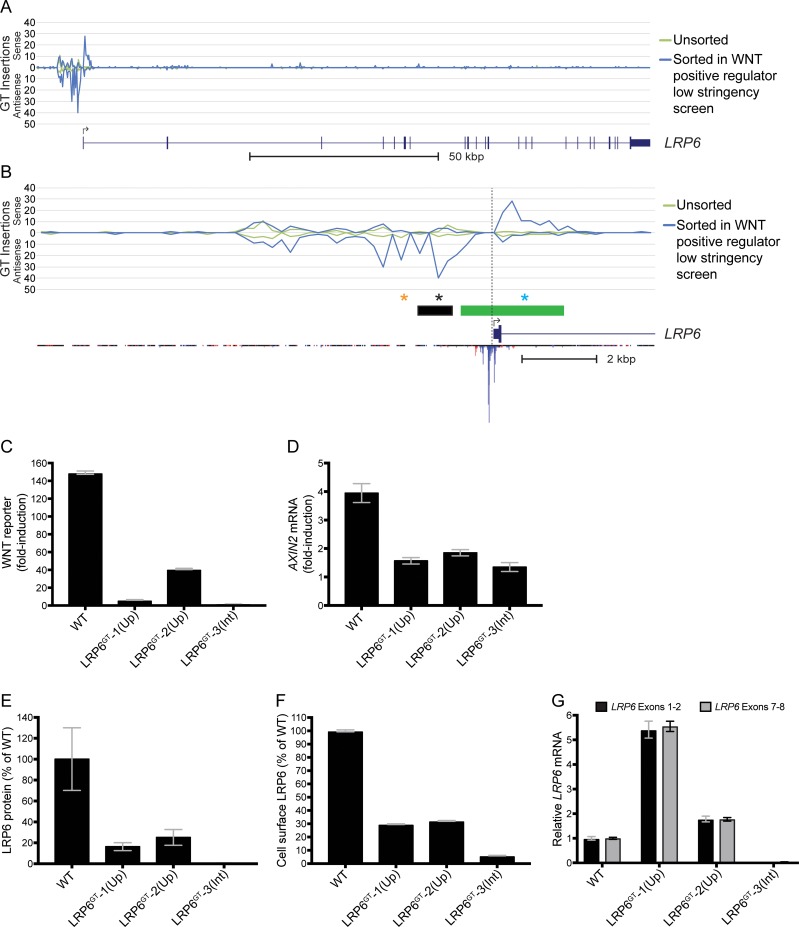
Antisense GT insertions upstream of LRP6 reduce LRP6 protein expression and impair WNT signaling.(A) The histogram indicates the number and orientation of GT insertions mapped to LRP6 and to the region ~12.5 kbp upstream of the TSS in unsorted cells and in the sorted cells from the WNT positive regulator low stringency screen. See legend to Fig 4A for details. The x-axis represents contiguous 250 bp bins to which insertions were mapped (Chromosome 12, 12116000–12279249 bp). (B) The histogram shows an expanded view of the 5’ end of LRP6 and the region ~12.5 kbp upstream of the TSS (left of the vertical dotted line), with traces for GT insertions mapped in unsorted cells and in the sorted cells from the WNT positive regulator low stringency screen. The x-axis represents contiguous 250 bp bins to which insertions were mapped (Chromosome 12, 12262500–12279249 bp). The green rectangle above the gene track indicates the location of the LRP6 promoter according to Ensembl and the black rectangle indicates the location of the bin identified in the upstream insertion enrichment analyses of the WNT positive regulator low stringency and high stringency screens. The black and orange stars denote the positions of the antisense GT insertions (located at NC_000012.13:g.12268371_12268372insGenetrap (Dec.2013: hg38, GRCh38) and NC_000012.13:g.12269383_12269384insGenetrap (Dec.2013: hg38, GRCh38) respectively [10]; see S2 File) in the LRP6GT-1(Up) and LRP6GT-2(Up) clonal cell lines, respectively, and the blue star denotes the position of the sense GT insertion (located at NC_000012.13:g.12266072_12266073insGenetrap (Dec.2013: hg38, GRCh38); see S2 File) in the LRP6GT-3(Int) cell line. The inverted histogram below the RefSeq gene track for LRP6 indicates the maximum CAGE read count found in any tissue sample from the FANTOM5 database [11]. (C) Fold-induction in WNT reporter (median +/- SEM EGFP fluorescence from 20,000 cells) following treatment with 50% WNT3A CM. (D) Fold-induction in AXIN2 mRNA (average +/- SD of AXIN2 mRNA normalized to HPRT1 mRNA, each measured in triplicate qPCR reactions) following treatment with 50% WNT3A CM. (E) Quantification of immunoblot analysis of total LRP6 protein (average +/- SD LRP6 intensity normalized to ACTIN intensity from samples run in duplicate) shown as percentage of WT HAP1-7TGP. The blot used for quantification is shown in C in S3 Fig. (F) Cell surface LRP6 protein (median +/- SEM cell surface LRP6 immunofluorescence from 20,000 cells) shown as percentage of WT HAP1-7TGP. (G) LRP6 mRNA (average +/- SD of LRP6 mRNA, measured using two different primer pairs, normalized to HPRT1 mRNA, each measured in triplicate qPCR reactions) shown relative to WT HAP1-7TGP cells.